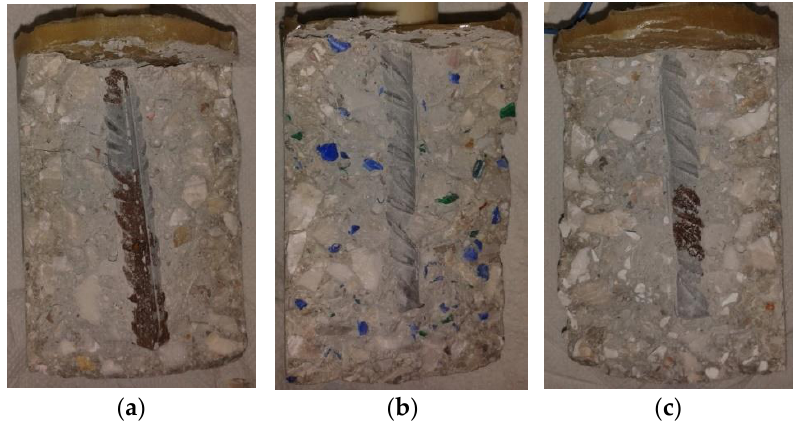
Figure 4. Specimen photos after splitting: ( a ) reference mix, ( b ) HDPE, ( c ) PP.